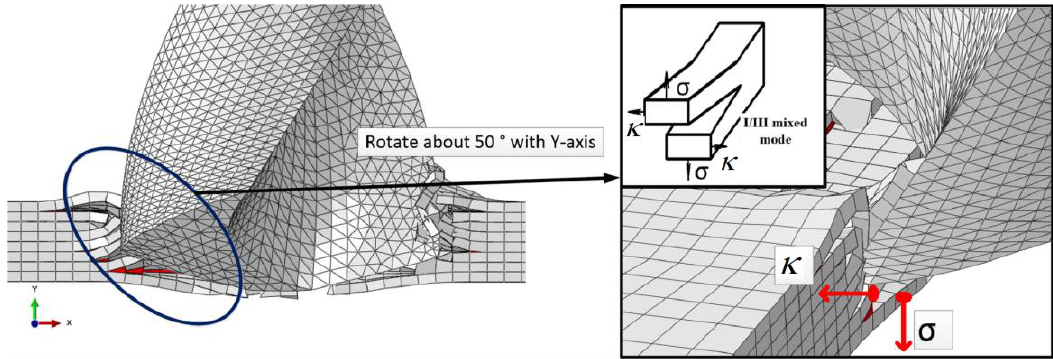
Figure 7. Crack form of main cutting edge at drilling exit.